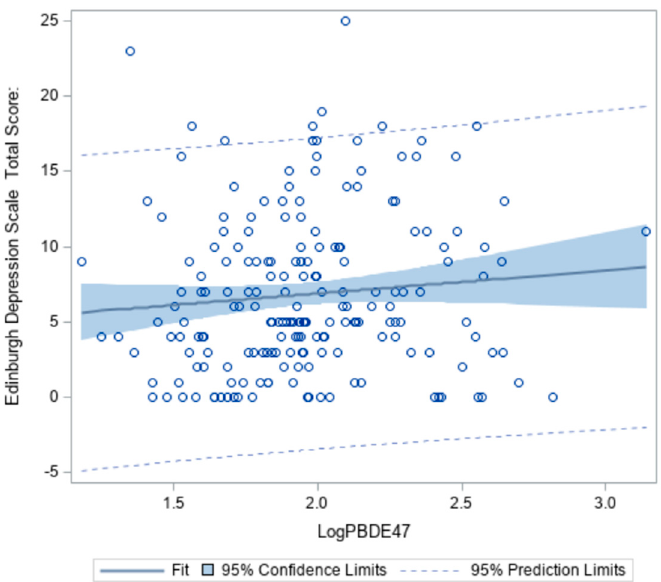
Figure 2. Association between BDE-47 (pg/mL) and Edinburgh Depression Scale Total Score among African American women at 18–14 weeks gestation (n = 193).